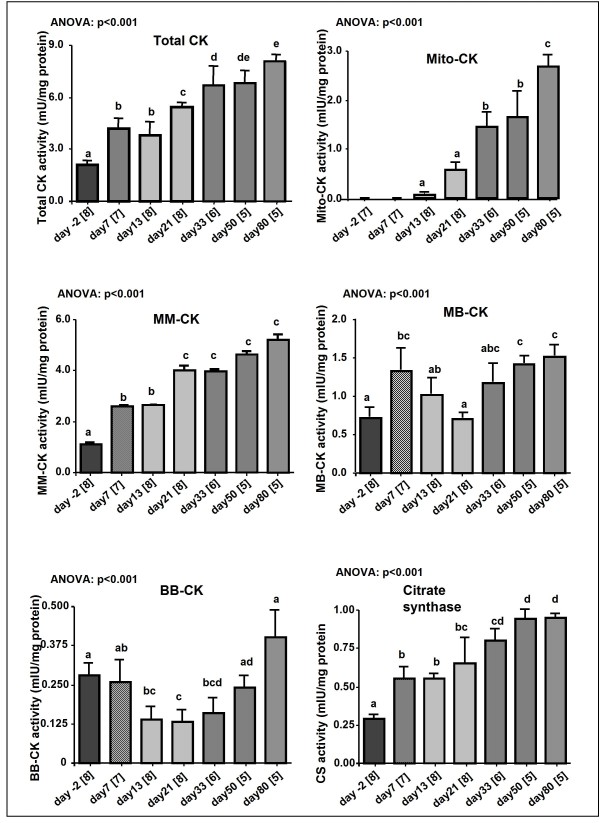
Total creatine kinase (CK) and its isoenzyme activities and citrate synthase (CS) activity during maturation. Values are means ± S.E. and sample size are given in brackets on the labels of the X axis. Data points with different superscript letters are significantly different to all other timepoints (p < 0.05, CK, CS: Bonferroni; Mito-CK, MM-CK, MB-CK, BB-CK: Dunnett T3, ANOVA "test for linear trend": as indicated).